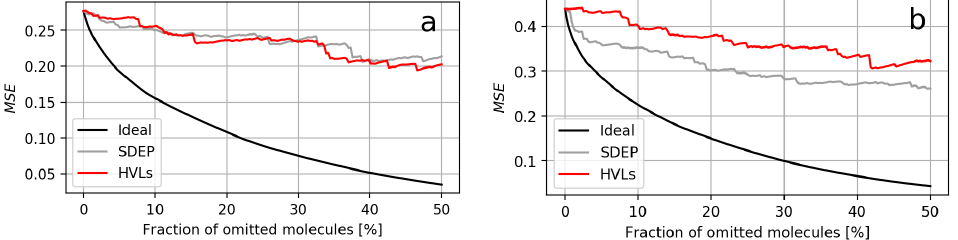
Figure 2. Two confidence curve plots from models using RDKit descriptors. ( a ) Plot of dataset F7, for which HVLs had the smallest area compared to that of the SDEP. ( b ) Plot of dataset Q16602, for which HVLs had the largest area compared to that of the SDEP.